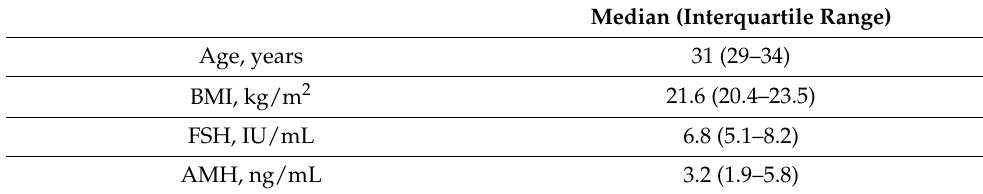
Table 1. Main patients’ characteristics and IVF cycle